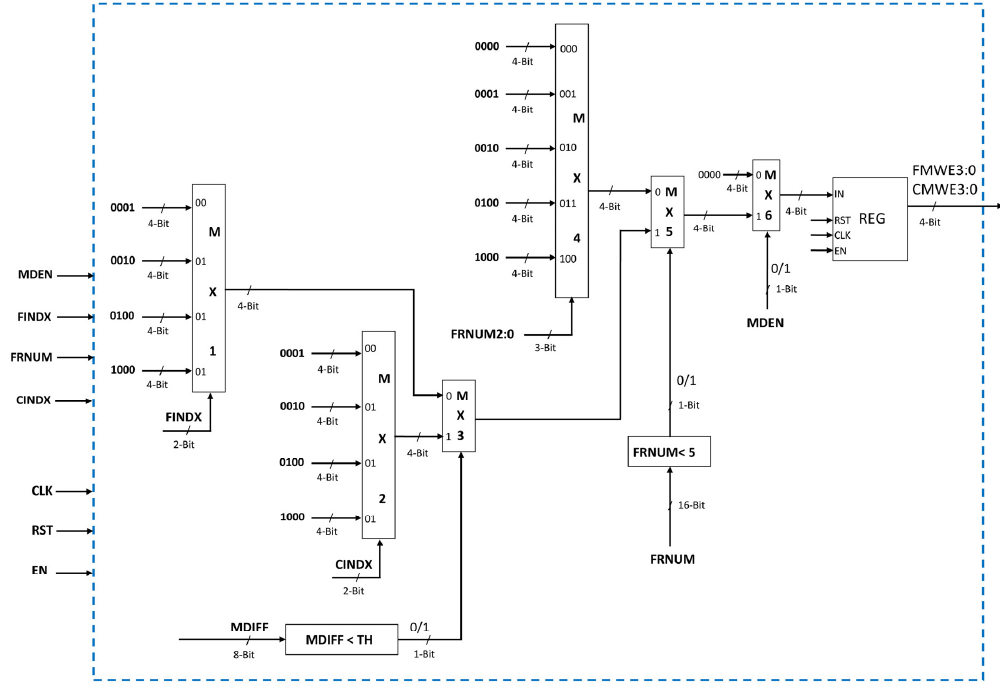
Figure 9. Parameter Memory (Centroid and Frame Number) Write Enable Signal Generation.